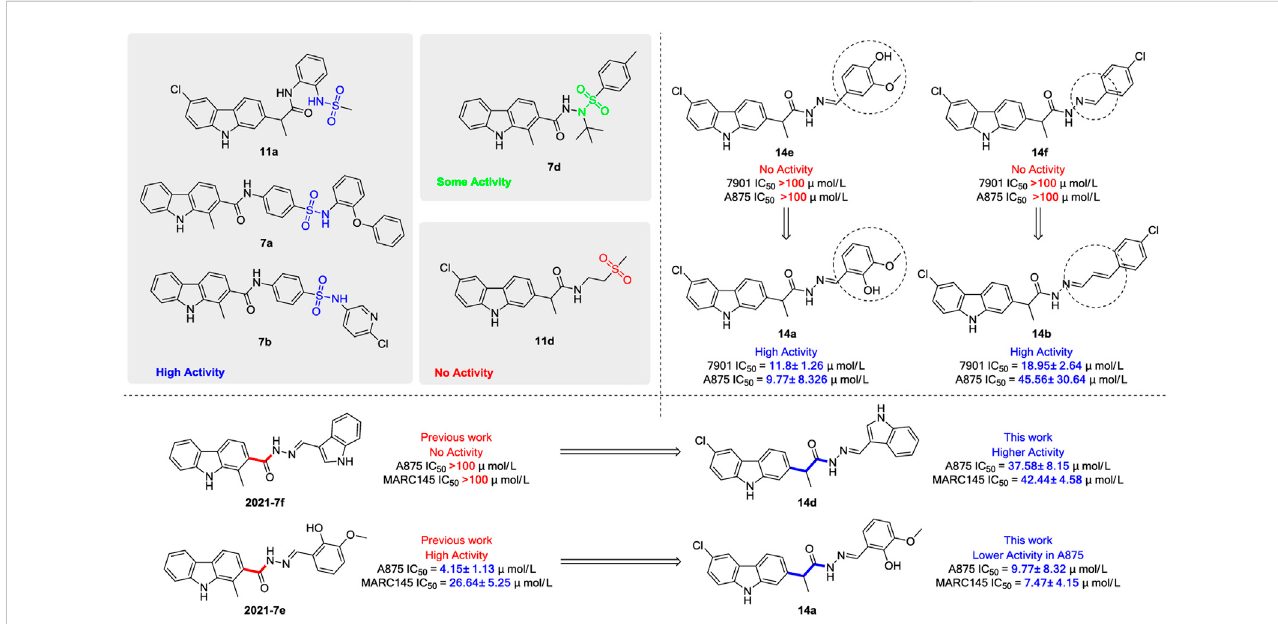
FIGURE 5 General structure-activity pro fi le for these carbazole derivatives and previous